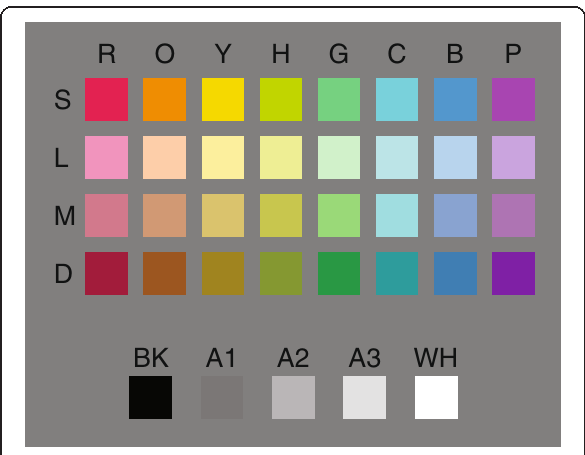
Fig. 3 The BCP-37 colors: eight hues ( left to right : Red, Orange, Yellow, cHartreuse, Green, Cyan, Blue, and Purple) sampled at four saturation/ lightness levels ( top to bottom : Saturated, Light, Muted, and Dark), plus five achromatic colors ( bottom row from left to right : black (BK), dark gray (A1), medium gray (A2), light gray (A3), and white (WH). Colors in the figure are for illustration only and are not colorimetrically accurate. See Additional file 1: Table S1 for coordinates in CIE 1931 xyY